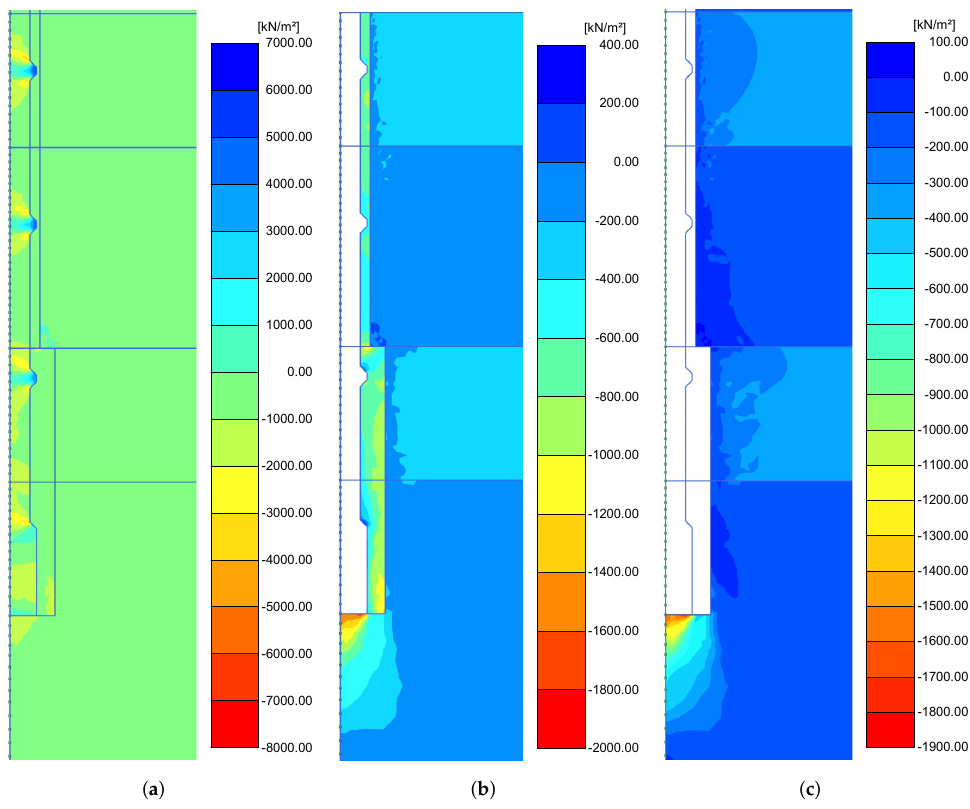
Figure 5. Vertical stress distribution cloud diagrams: ( a ) part of nodular joints, ( b ) cement soil around the joints, and ( c ) soil around the